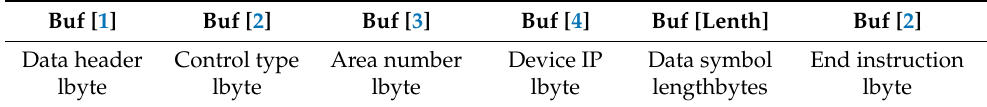
Table 1. Platform and controller communication protocol.